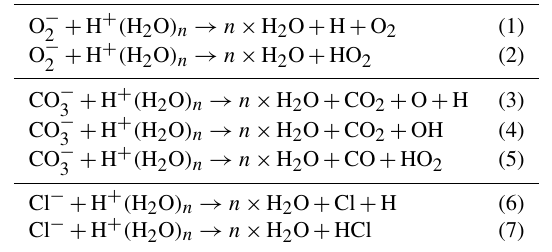
Table 5. Possible recombination reactions of proton hydrates with O − , CO − , and Cl − considered in the model. Simulations have been 2 3 performed for the combinations: (1)–(3)–(6), (1)–(4)–(7), (1)–(5)– (6), (1)–(5)–(7), and (2)–(5)–(6), which include cases of maximum direct HO 2 formation with maximum HO x production as well as minimum direct HO 2 formation with minimum HO x